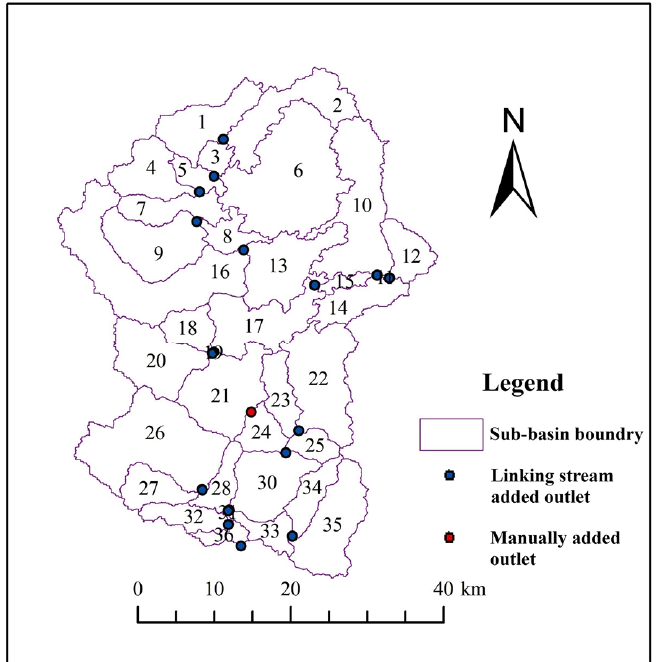
Figure 5. Division of sub-basins in the Chengbi River basin.